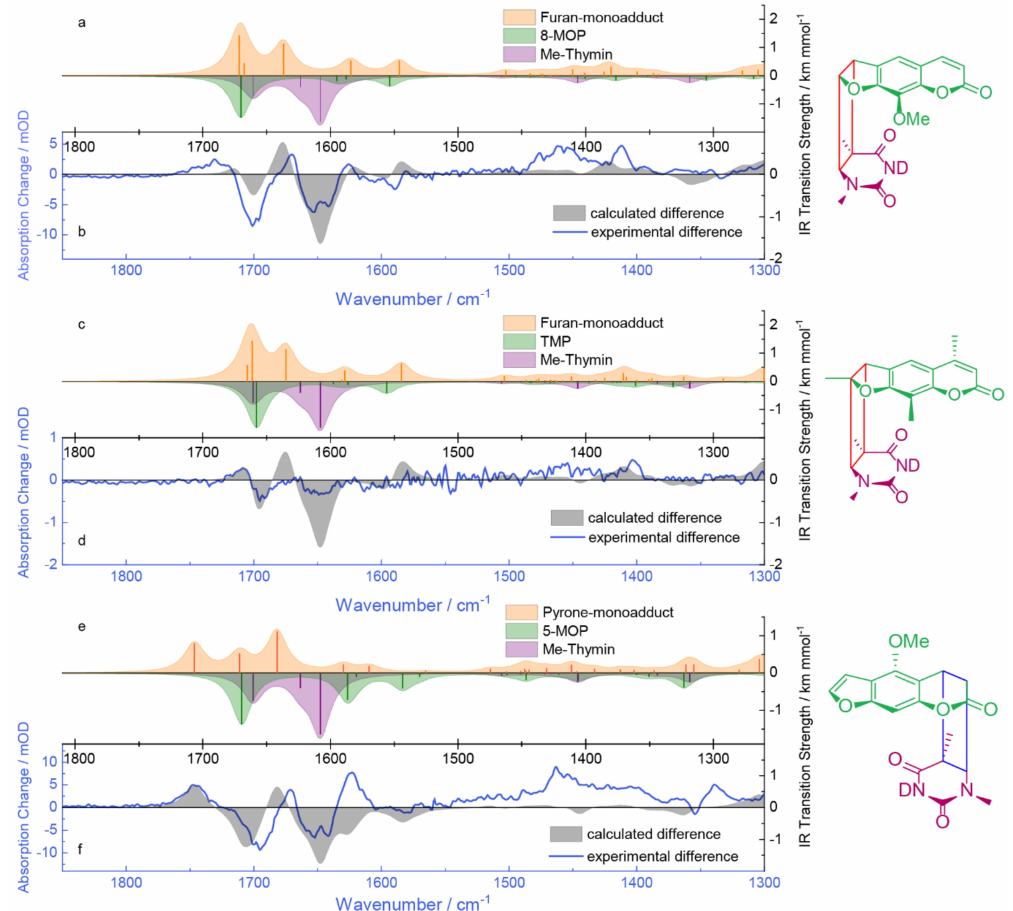
Figure 4. IR signatures of photoaddition computed by quantum chemistry in comparison with the experimental data: ( a , c , e ) IR spectra of psoralens, 1-methylthymine and their respective photo-products obtained from a DFT calculation with the B3LYP functional and a 6-31 + G* basis set (scaling factor 0.96). Stick spectra were converted into the presented ones by convolution with Lorentzians (full width at half maximum (FWHM) of 20 cm − 1 ). The spectra of the psoralens and 1-methylthymine are inverted to highlight possible bleach contributions; ( b , d , f ) Comparison of calculated di ff erence and experimental di ff erence absorption. The blue X-axes (experimental di ff erence) is shifted by 40 cm − 1 to higher wavenumbers relative to the black X-axes (computational di ff erences). Structures of the respective photo-products are depicted on the